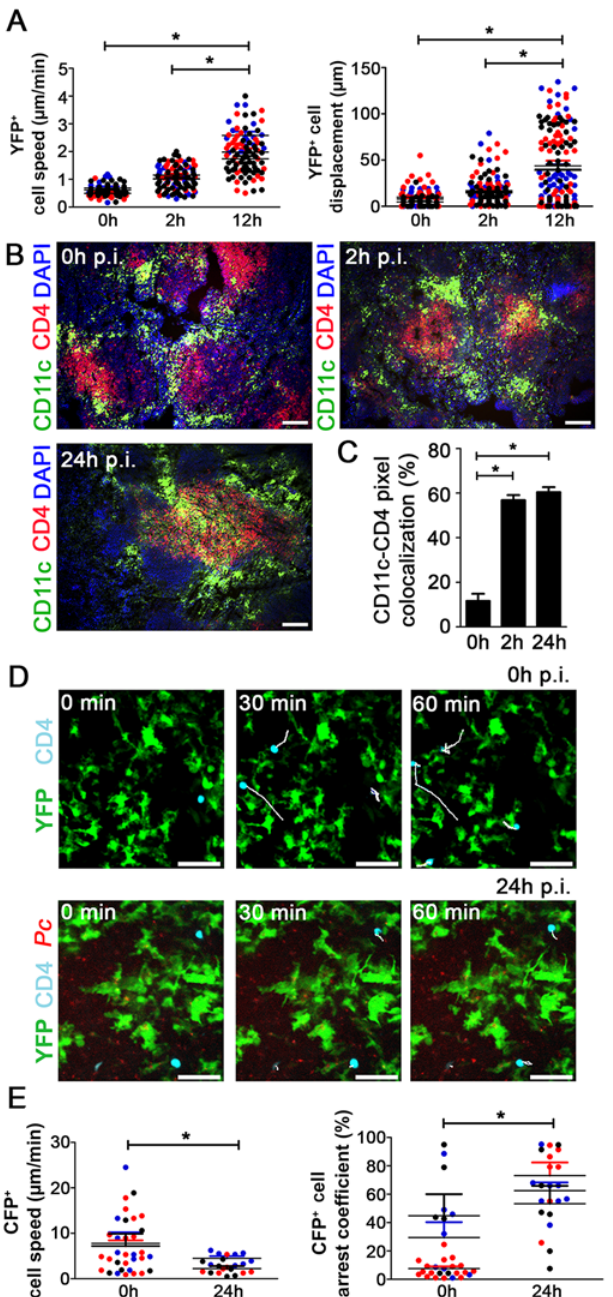
Figure 4. Analysis of the interactions between splenic DCs and CD4 + T cells after Pc infection. (A) B6. CD11c-YFP mice were i.p. infected with 1 × 10 6 mCherry- Pc iRBCs. Spleens were analyzed by CIVM after 2 h and 12 h and in non-infected controls. Speed and displacement of YFP + cells are shown. Black, red and blue dots are from three different experiments. Horizontal lines represent mean values and SEM. (B and C) B6 mice were i.p. infected with 1 × 10 6 mCherry- Pc iRBCs. Spleens were analyzed after 2 h or 24 h and in non-infected controls. (B) Representative immunofluorescence images (10x magnification) show CD11c + cells and CD4 + cells in DAPI-stained tissue sections. (C) Percentages of CD11c pixels colocalized with GFP pixels in the immunofluorescence images are shown (means ± SD). (D and E) B6.CD11c-YFP mice were adoptively transferred with 5 × 10 6 CFP + CD4 + T cells and i.p. infected with 1 × 10 6 mCherry- Pc iRBCs. Spleens were analyzed by CIVM after 24 h and in non-infected controls. (D) Snapshots show the subcapsular RP with CFP + CD4 + cell tracking. (E) Speed and arrest coefficients of CFP + CD4 + cells are shown. Black, red